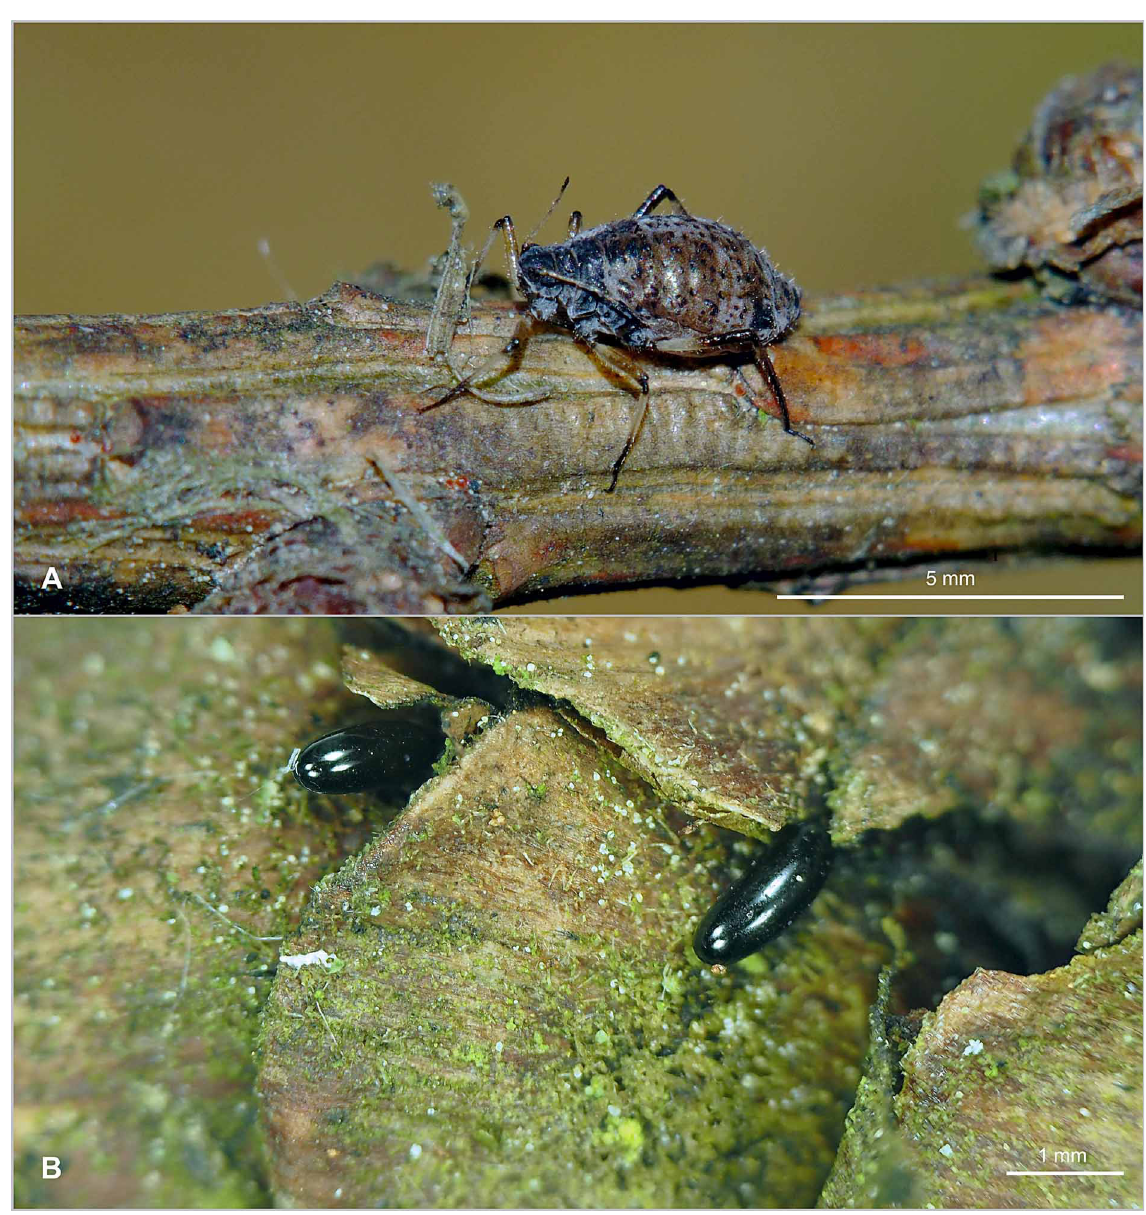
Fig. 65. Cinara (Cinara) laricis (Hartig, 1839) on Larix decidua in late autumn. A . Ovipara on twig. B . Eggs between scales of previous year’s cone. Preanal wax ring absent in the ovipara, hence the eggs without wax